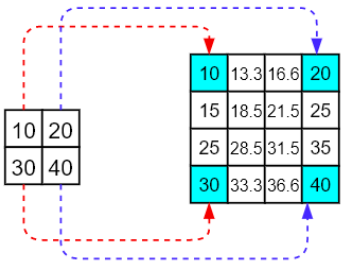
Figure 6. Example of bilinear interpolation.